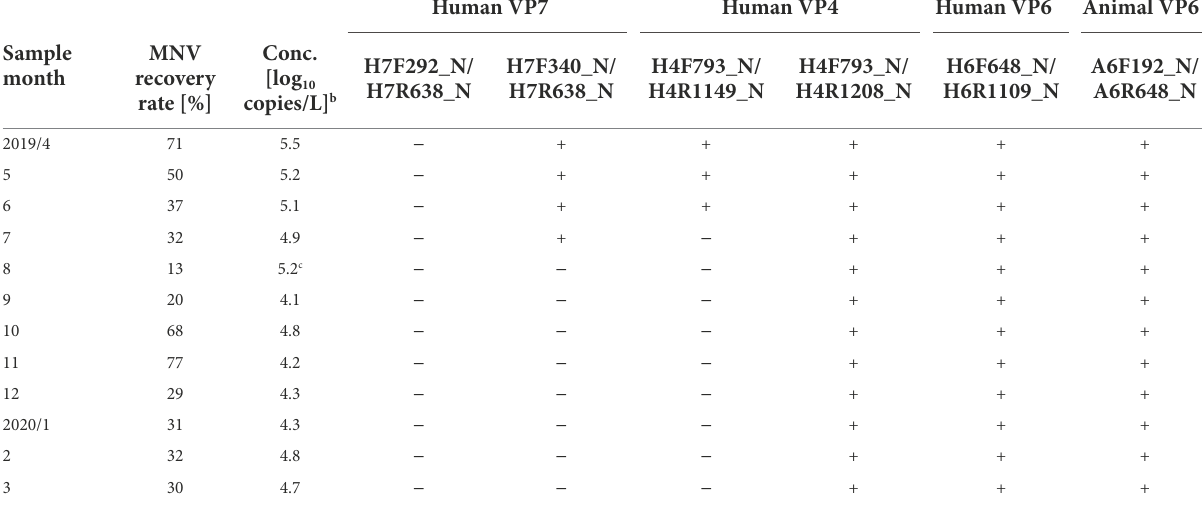
TABLE 2 Sensitivity of developed nested PCR assays evaluated using Sample Set 1.